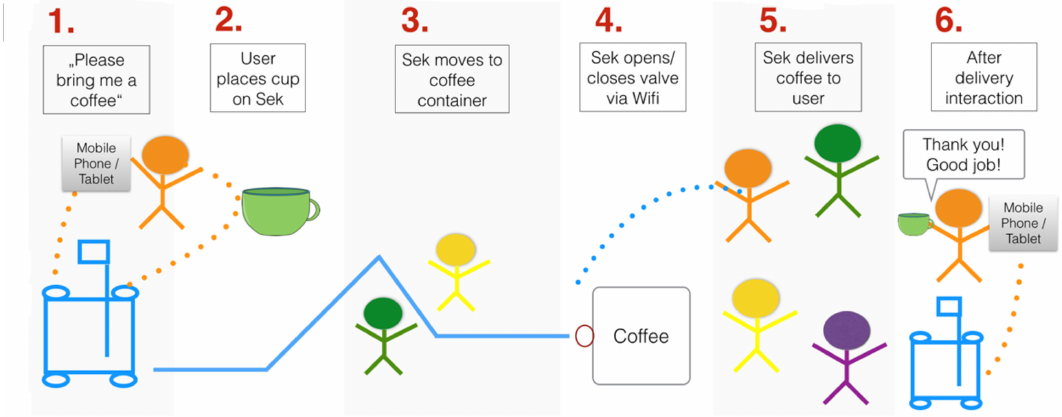
Figure 2. A graphic depiction of our mobile device for HRI demonstration, showing the process of placing an order, having the